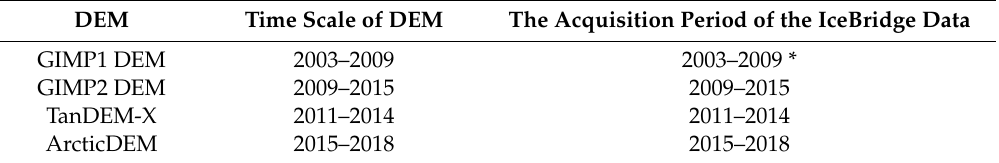
Table2. TheacquisitionperiodoftheIceBridgedatausedinrelationtoeachDEMdataset. *TheIceBridge data exclude the year 2004 because the data in 2004 were inconsistent with other years.